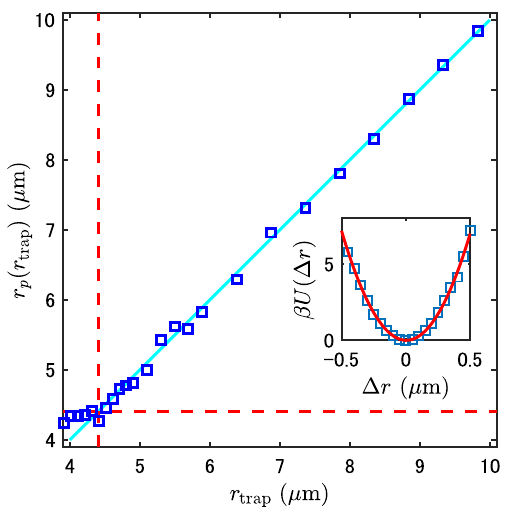
FIG. 6. Direct observation of lack of long-ranged inter- actions in the hard-sphere system. We show the optical trapping measurement of the interaction between a pair of core-shell OCULI particles in a pair of weak optical traps at different separations. There is no deviation between interpar- ticle separation r and trap positions r until the particles p trap meet, at which point the interparticle separation becomes constant. This case is consistent with a hard-sphere- like separation. Inset: estimate of the optical confinement potential U ð Δ r Þ